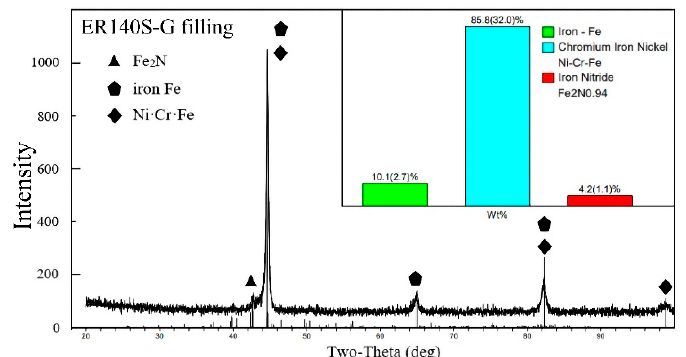
Figure 6. XRD phase detection spectrum (ER140S-G filling).